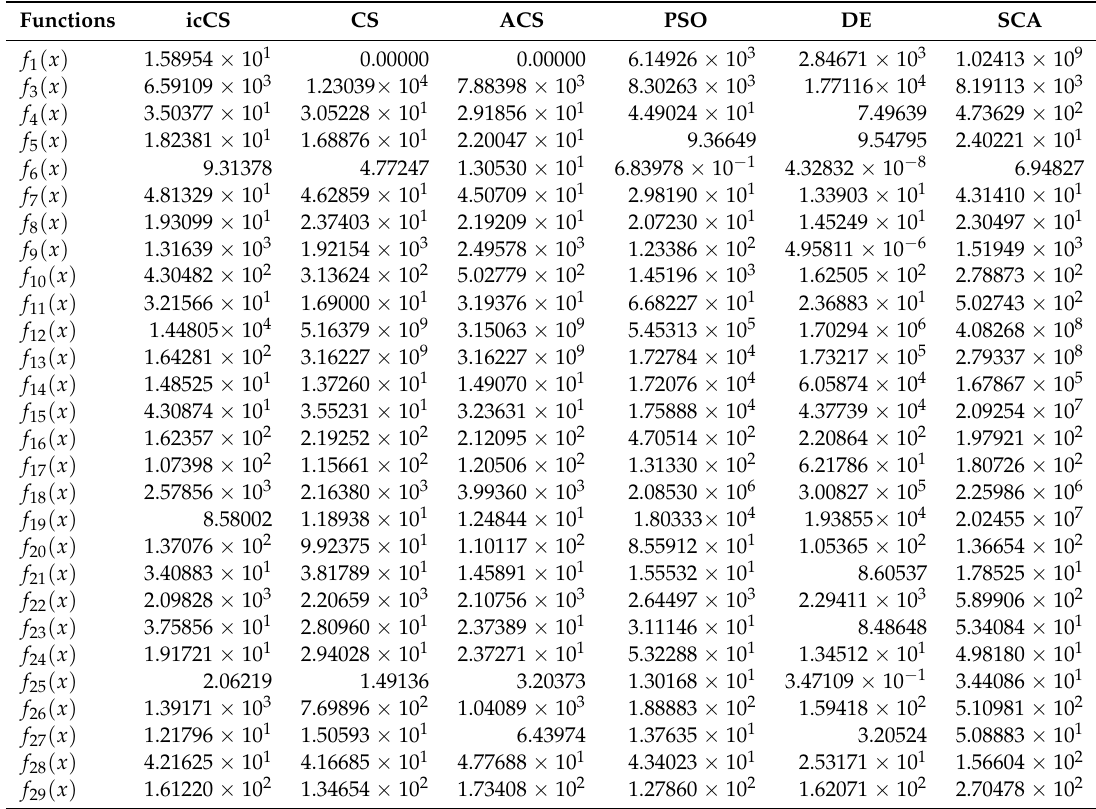
Table 3. Comparison of standard deviation of Fitness Functions on 30D optimization among CS, ACS, PSO, DE, SCA, and icCS is presented